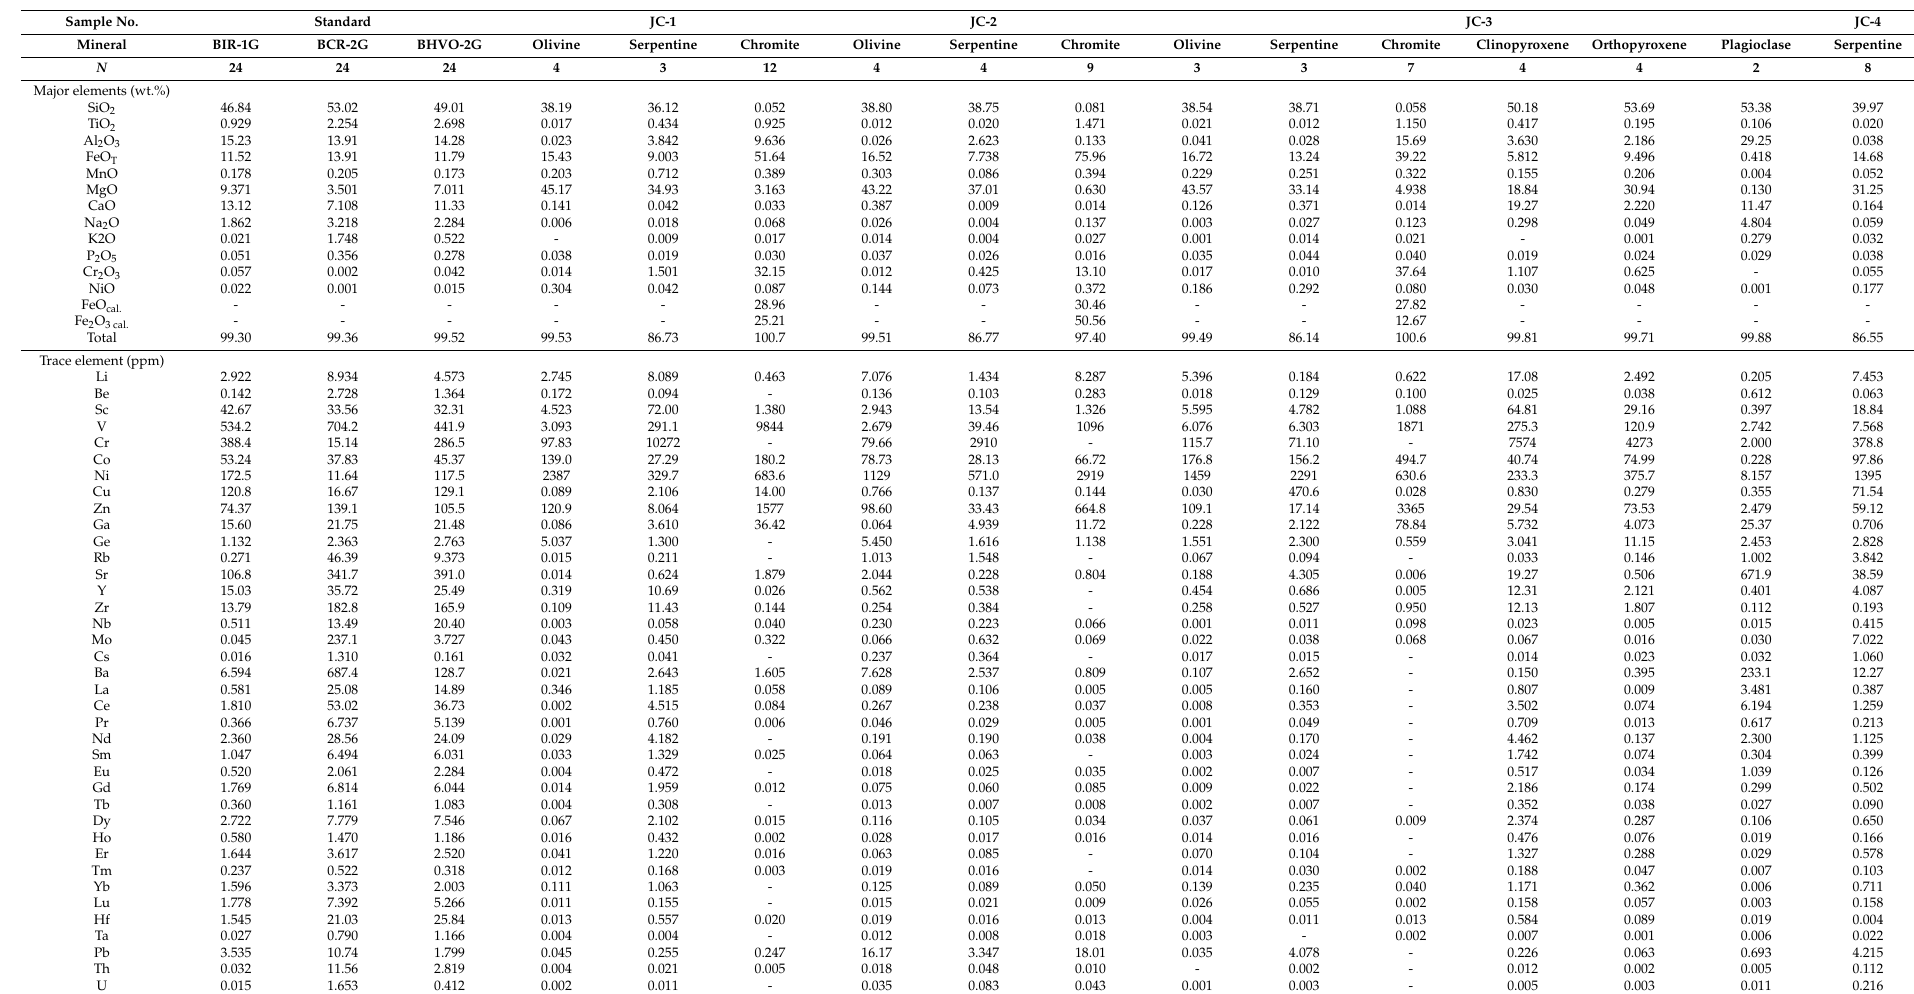
Table 3. Representative microprobe analyses of silicate and oxide minerals of ore samples in the Jinchuan deposit by LA-ICP-MS.